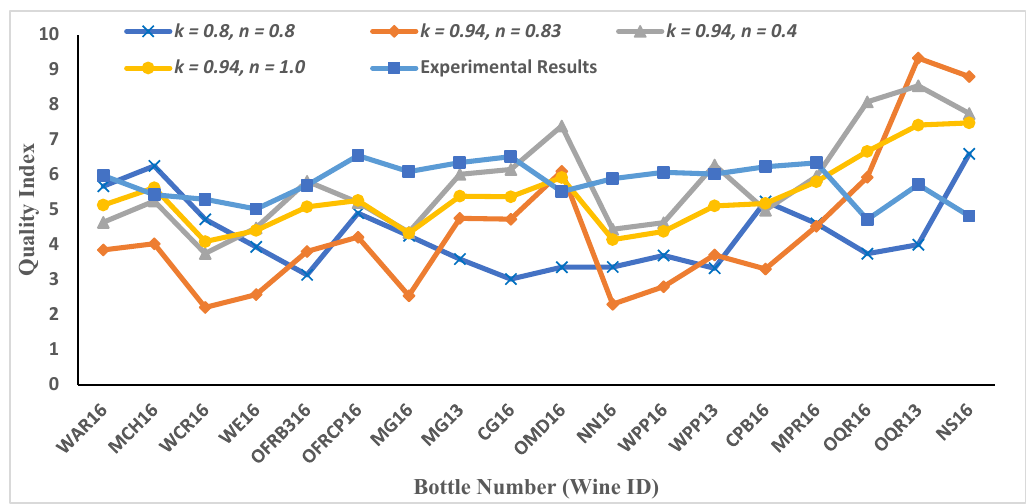
Figure 7. Wine quality results for case study 1 for data2. As explained in Equation (9), we assumed (cid:3041) (cid:3118) (cid:3404) 𝛼 (cid:3404) 𝑛 . Different values of the parameter 𝑘 are considered in contrast with the value of 𝑘 (cid:3041) (cid:3117)